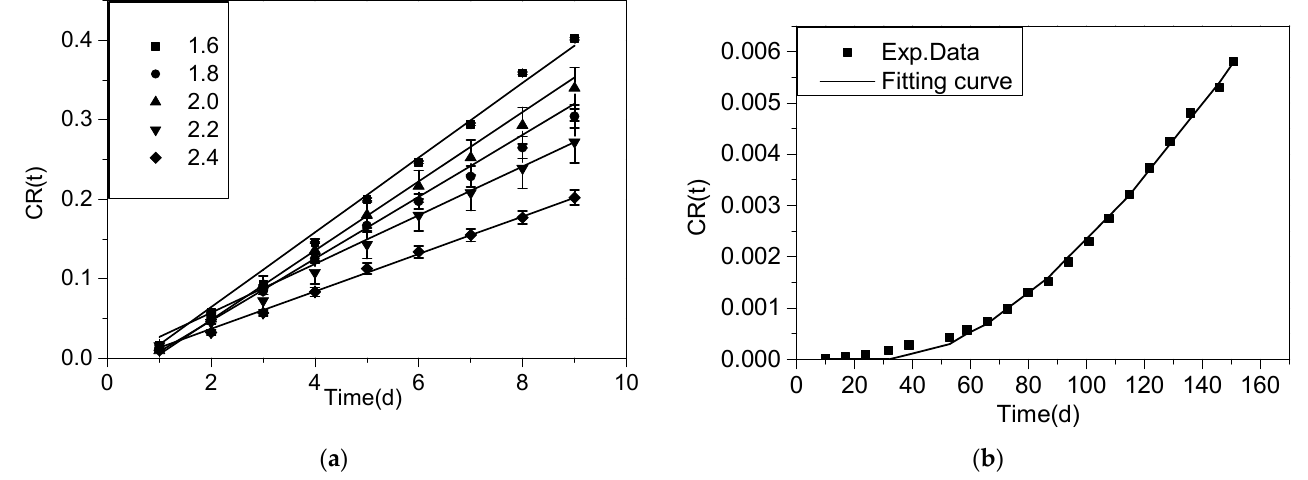
Figure 4. Diffusion of HTO and Se in compacted and intact TMS clay rocks: ( a ) HTO; ( b ) Se.